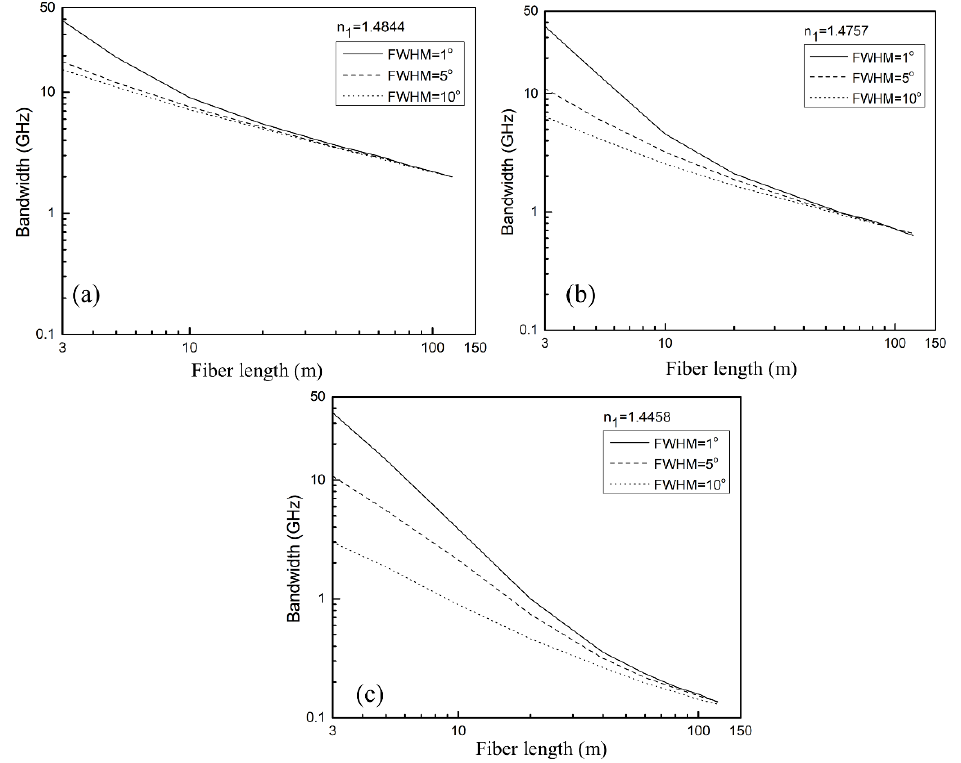
Figure 3. Bandwidth versus fiber length for multimode SI PPCF for three Gaussian launch beam widths with (FWHM) z=0 = 1, 5, and 10° for ( a ) d =1 µm ( 𝑛 (cid:2869) = 1.4844), ( b ) d =1.5 µm ( 𝑛 (cid:2869) = 1.4757) and ( c ) d = 2 µm ( 𝑛 (cid:2869) = 1.4458).